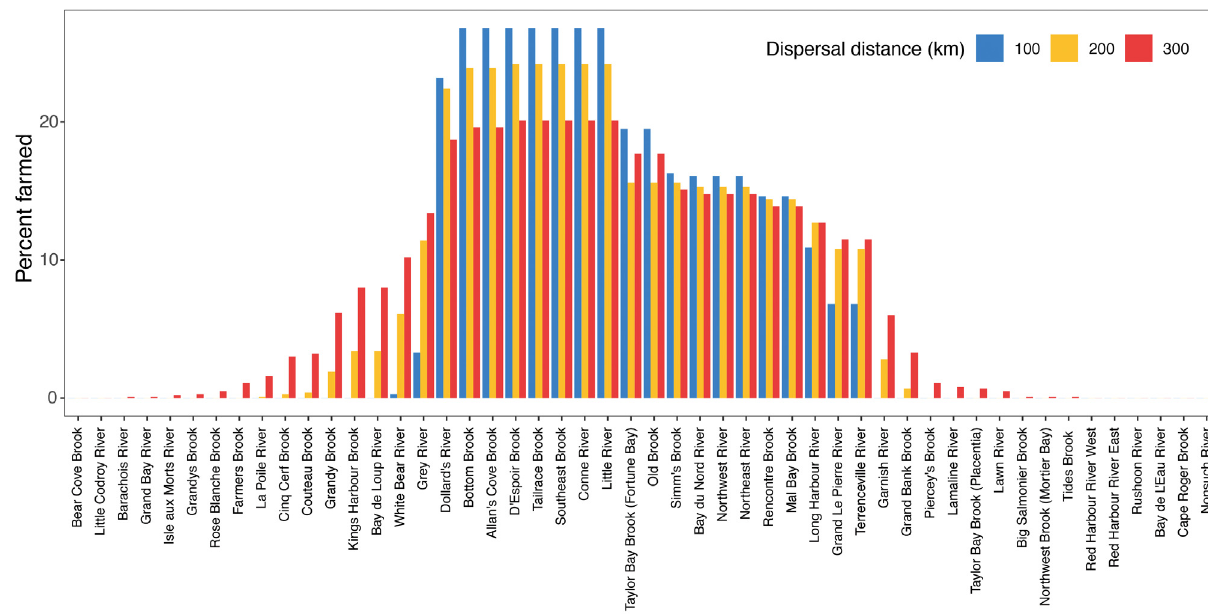
Fig. 8. Predicted relative percentage of escaped farmed salmon to wild salmon in rivers of southern Newfoundland under the proposed expansion scenario, varying the maximum dispersal distance for escapees. See Section 2 for details regarding simula- tions. Rivers are arranged west to east along the x